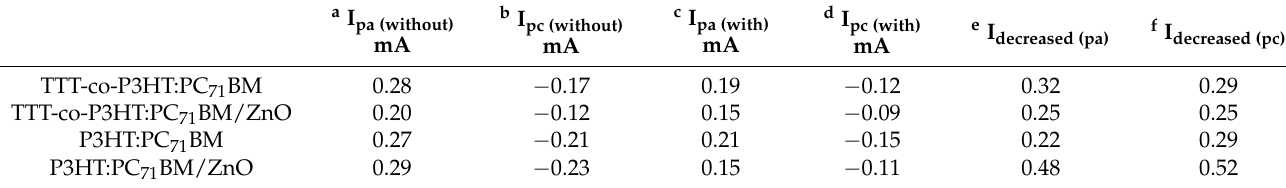
Table 5. Cathodic and anodic peak currents obtained from CV used to study the effect of PEDOT:PSS